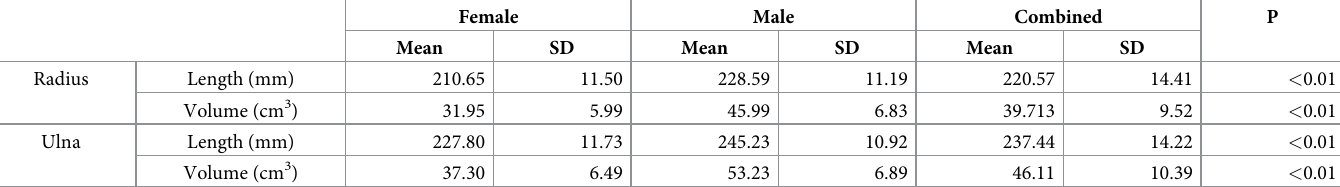
Table 1. Length and volume of the radius and ulna.